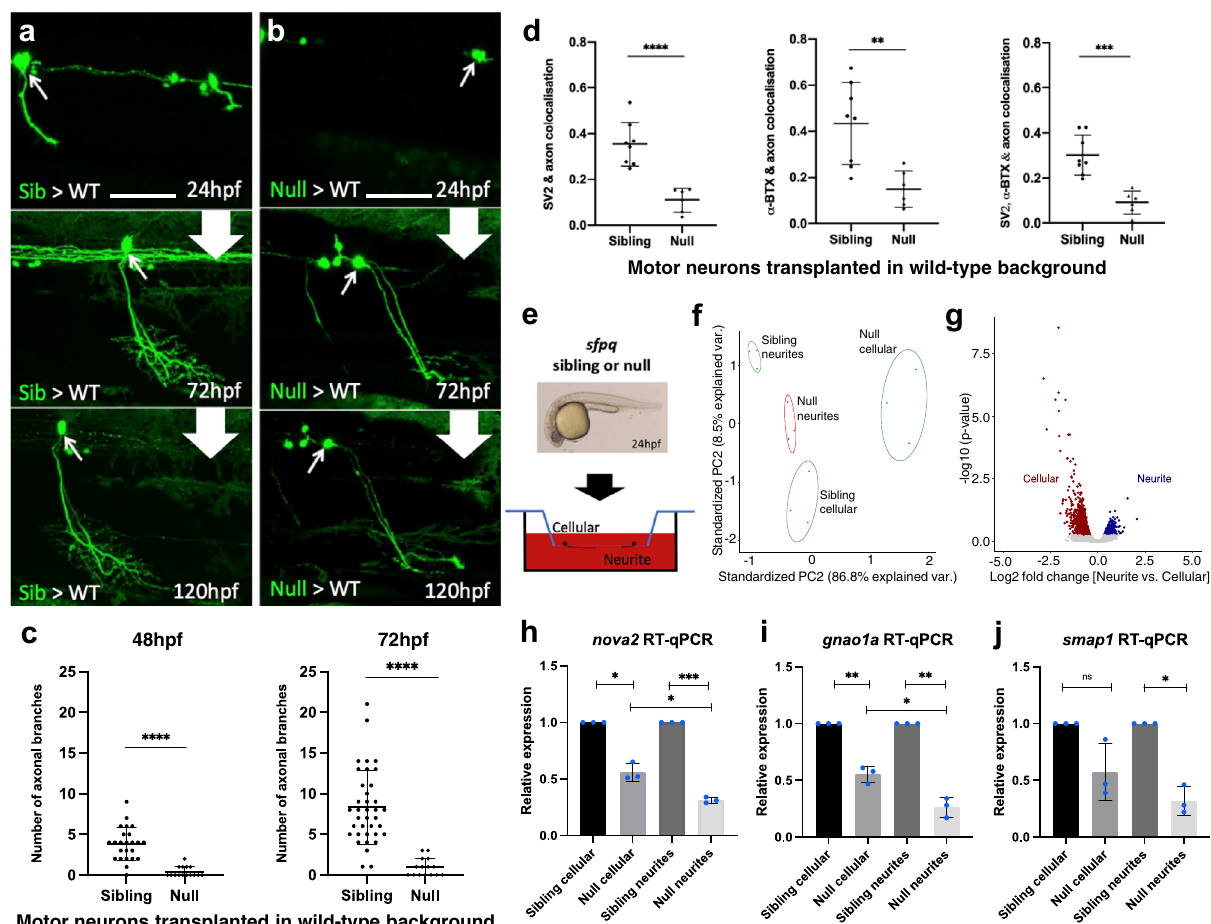
Fig. 1 | Characterisation of the impact of SFPQ-depletion on neurites. a , b Confocal z-projections (150 μ m), lateral view, anterior to the left, of trans- planted sfpq; tg(mnx1:GFP) sibling ( a ) & null ( b ) motor neurons in wild-type hosts. Scale bar 25 μ m. c Quanti fi cation of all branches on transplanted sibling and null GFP+motorneurons at48hpf (Left) and 72hpf (Right).Eachdatapoint represents an individual neuron. Two-tailed, unpaired t tests with Welch ’ s correction. Means plottedwithSD.(48hpf)Sibling:24neurons,9hosts(6donors),Null:15neurons,4 hosts (4 donors), **** p <0.0001. (72hpf) Sibling: 37 neurons, 14 hosts (11 donors), calisationwithsynapticmarkers.Theportionofaxonoverlappingwitheachmarker was calculated. Each point represents an axon of a different neuron. Sibling, n: